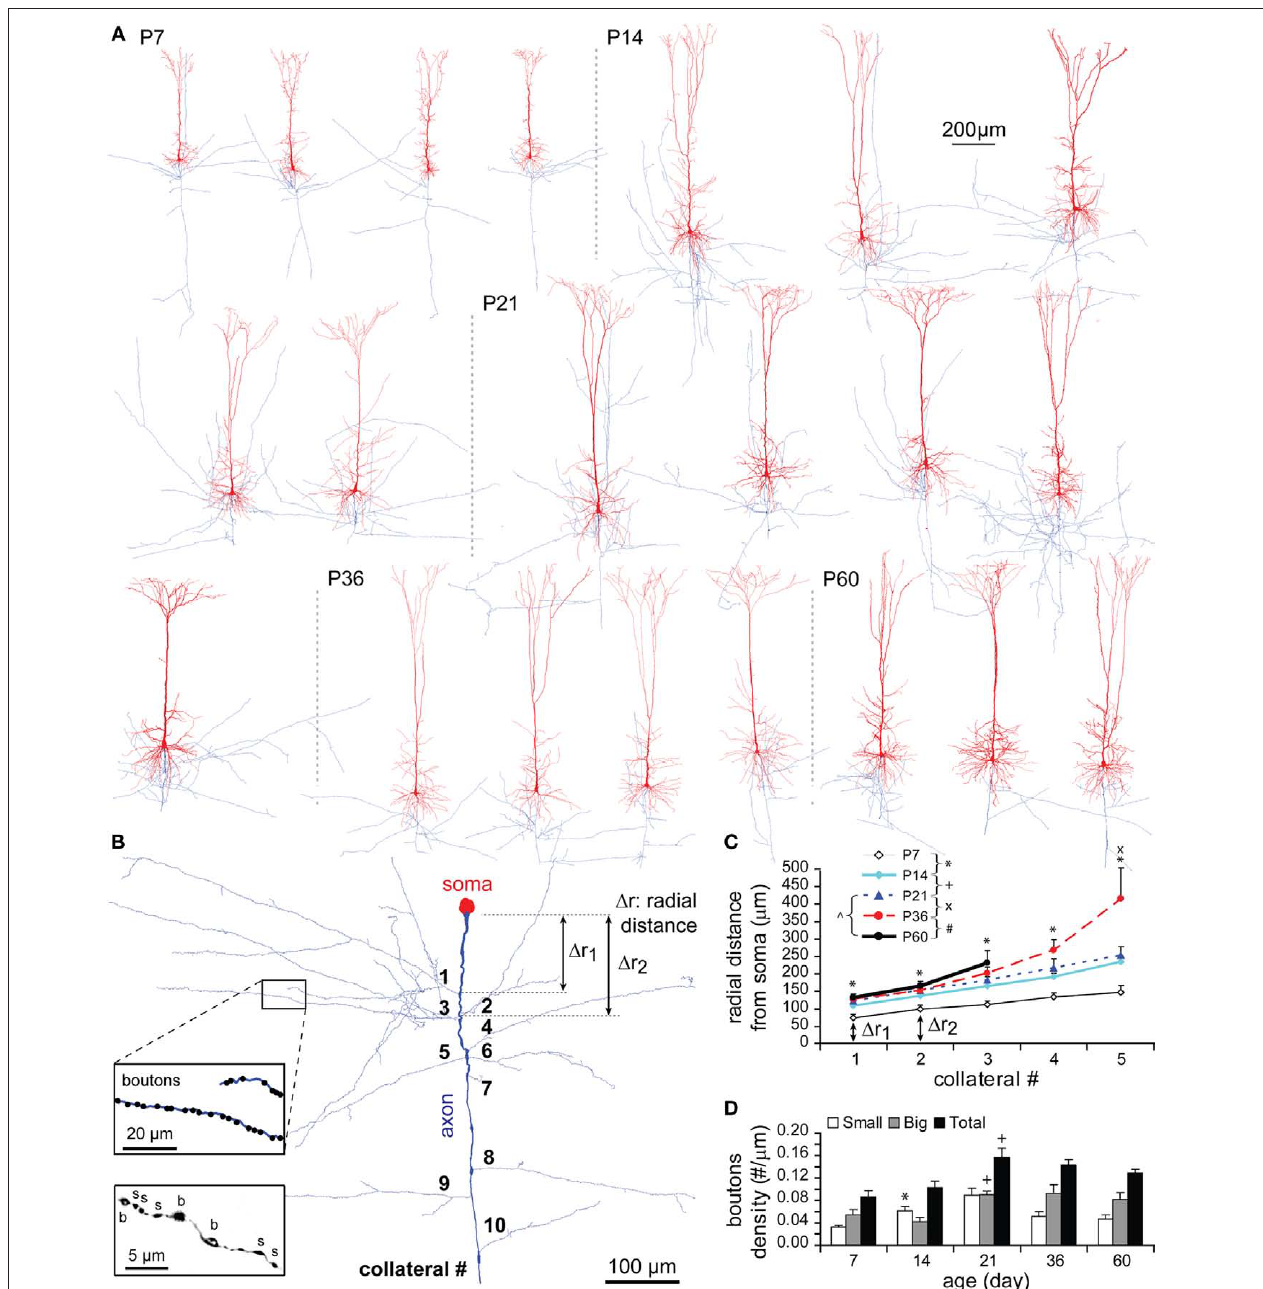
n = 8, P14: n = 15, P21: n = 12, P36: n = 9, P60: n = 4). A significant increase in the radial distance was tested from P7 to P14 to all the collateral stems, but a further increase from P21 to P36 was significant only to the most distal fifth collateral stem. (D) Bouton density on the whole axon (total number of boutons/ total axon length) for small, big, and total boutons (P7: n = 8, P14: n = 13, P21: n = 6, P36: n = 3, P60: n = 3). A significant increase was shown from P7 to P14 in the density of small boutons, and from P14 to P21 in the density of large boutons and the density of total